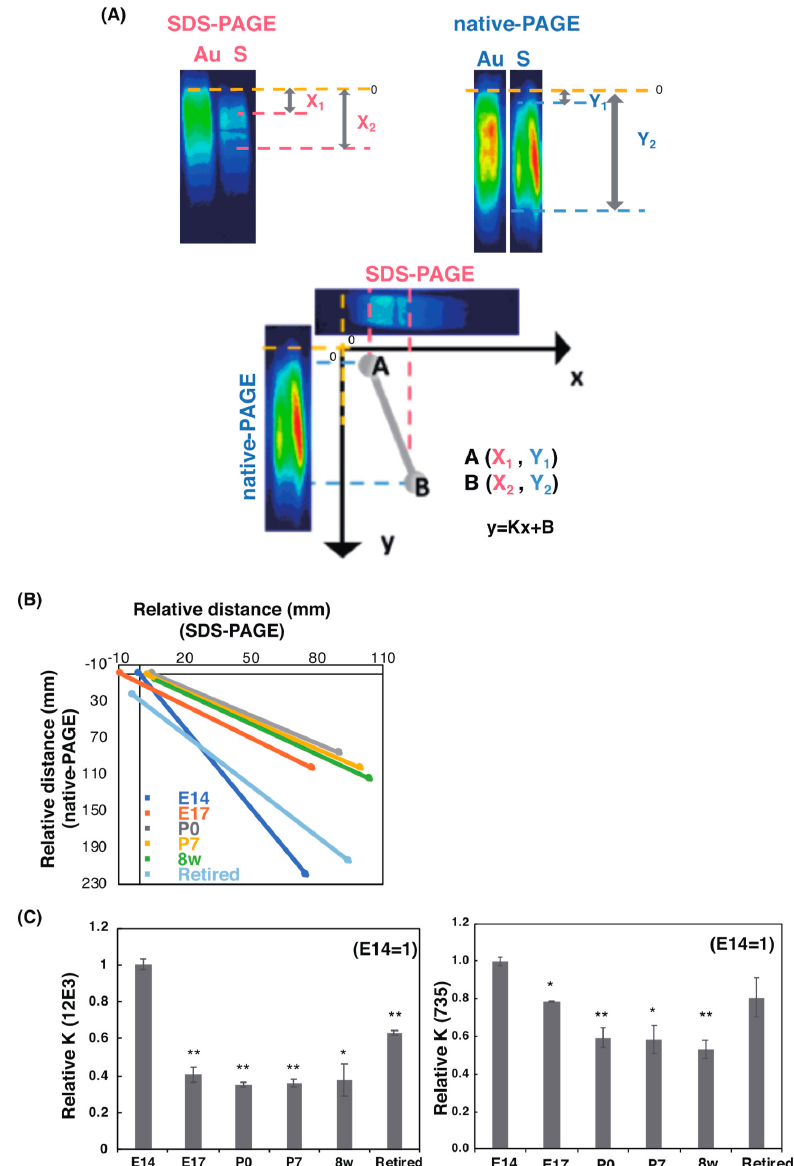
Figure 4. SDS-PAGE/Native PAGE MAP. The S/N MAP of brains at six different developmental stages was described based on the results of blots with each antibody. ( A ) The staining in Figures 2 and 3 were changed to the pseudo color. The top of the staining of E14 was set as the origin (upper panel). The S/N map was obtained (lower panel) based on plot A (X 1 , Y 1 ) and B (X 2 , Y 2 ). Au: authentic sample; S: sample. ( B ) The S/N map of 12E3 staining ( n = 1). The correlation curve of six different developmental brains is shown. ( C ) Relative slope value, K. The value of E14 was set to 1.0. The left panel shows 12E3 and the right panel shows 735. The values were obtained from the S/N maps from 6 different stage ( n = 3). * p < 0.05. ** p < 0.01.